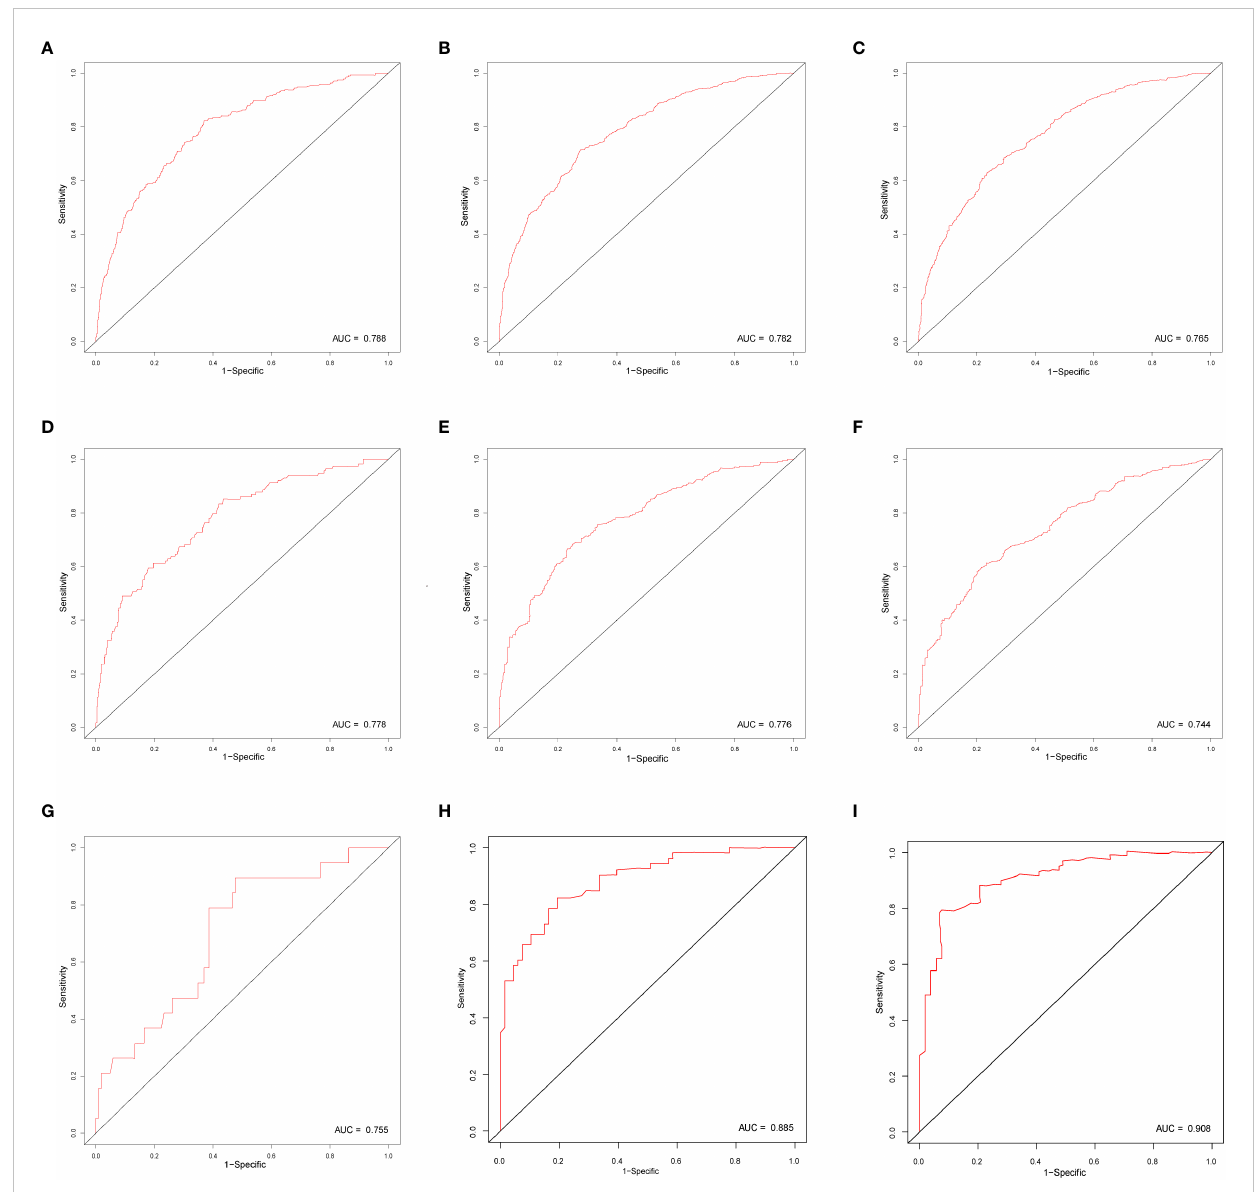
FIGURE 3 The ROC curve of nomograms to predict 1-, 2-, and 3-year overall survival in the training cohort (A – C) , validation cohort (D – F) , and testing cohort (G – I)